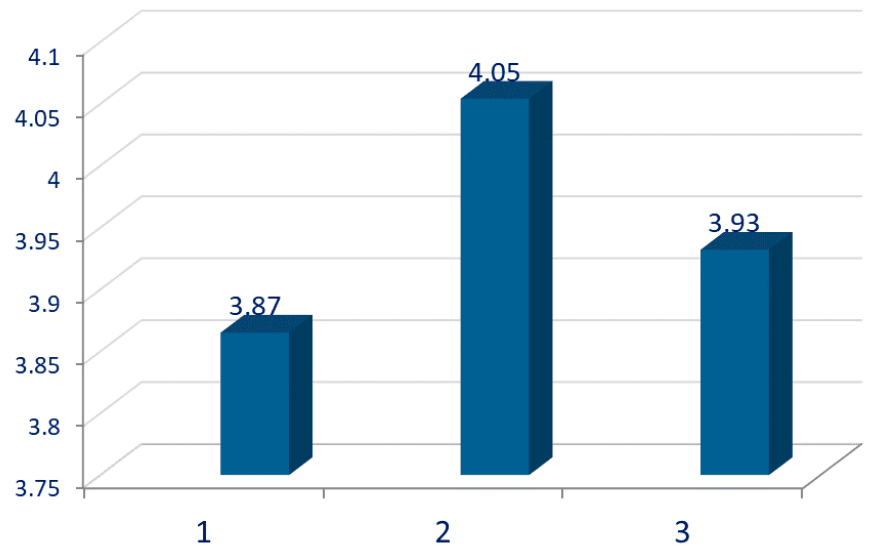
Figure 2. Consumer’s average sensory score of evaluated cheeses ( p = 0.10) using a scale of 1 to 5 (1 = unacceptable and 5 = very acceptable). 1—without milk standardization; 2—standardization casein/fat = 0.7 by addition of skimmed milk powder; 3—standardization casein/fat = 0.7 by skimming part of the milk fat.